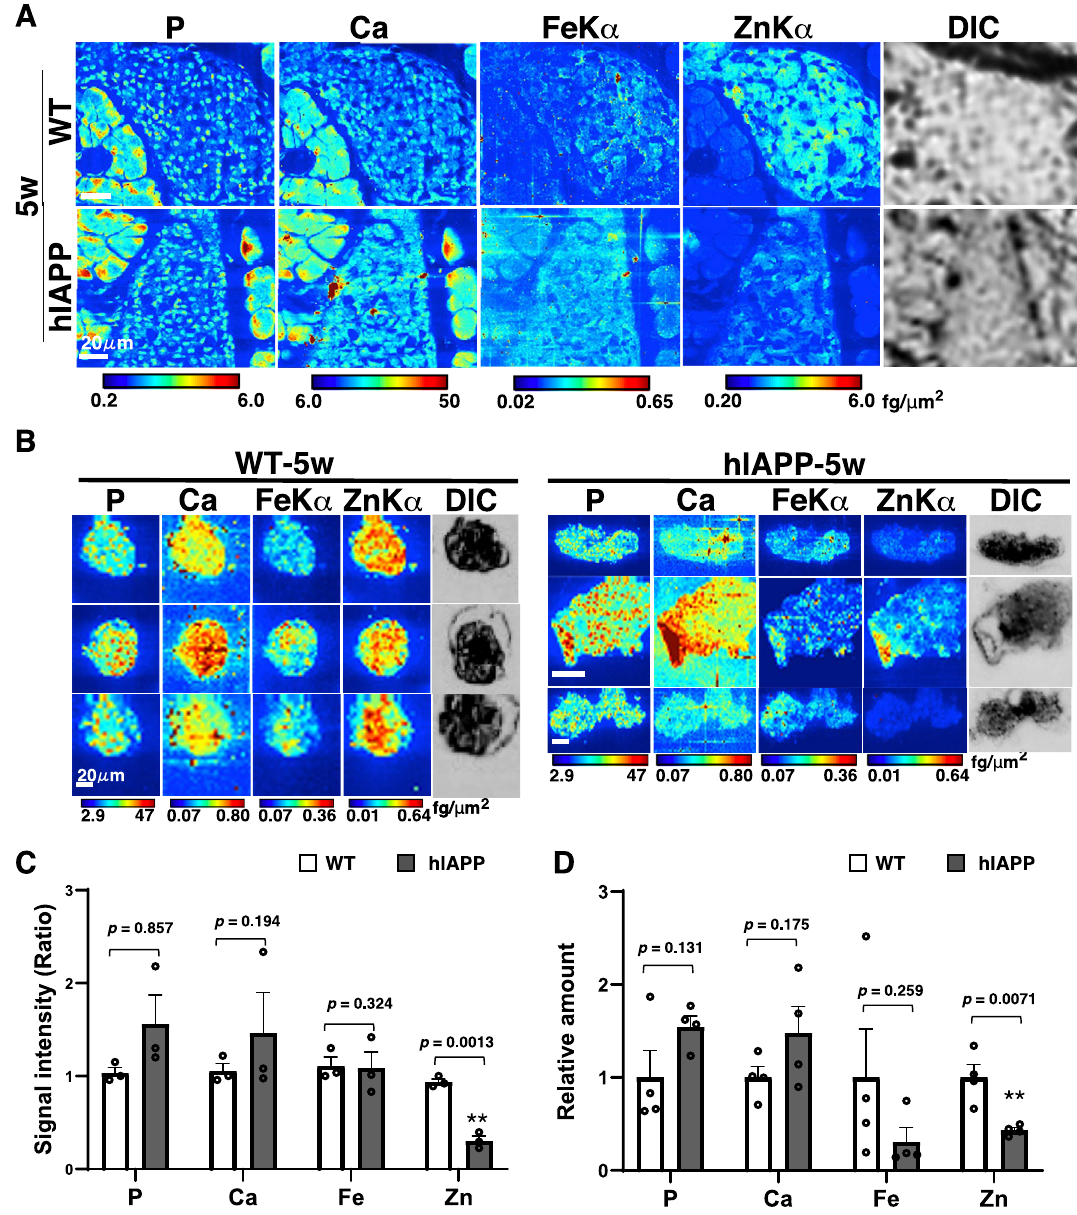
Figure 3. Decreased zinc in islets of 5-week-old hIAPP-Tg mice. ( A ) Mapping images of pancreatic islets from 5-week-old mice. ( B ) Mapping images of isolated islets from 5-week-old mice. Color bar, femtograms per square micrometer; DIC: differential interference contrast image; Scale bar, 20 μm. ( C ) Quantification of signal intensities in ( B ). ( D ) Relative amounts of each element in isolated islets were measured using ICP-MS (n = 4 for each genotype). WT: WT mice, hIAPP: hIAPP-Tg mice, Data are shown as means ± SEM. ** p < 0.01 (WT vs.